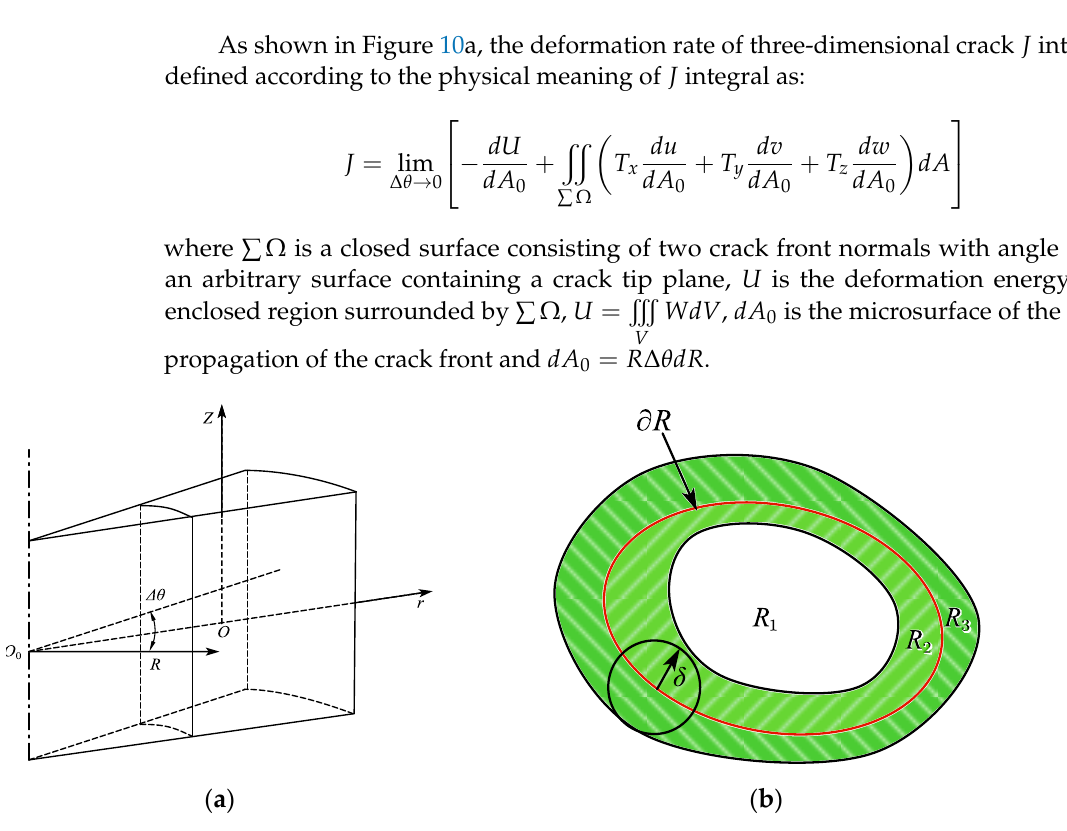
Figure 10. Equivalent J -integration based on peridynamic theory. ( a ) Three-dimensional crack J integral region. ( b ) Equivalent stress factor.